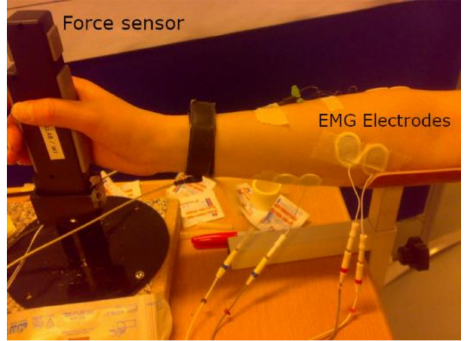
Figure 5. The considered experimental